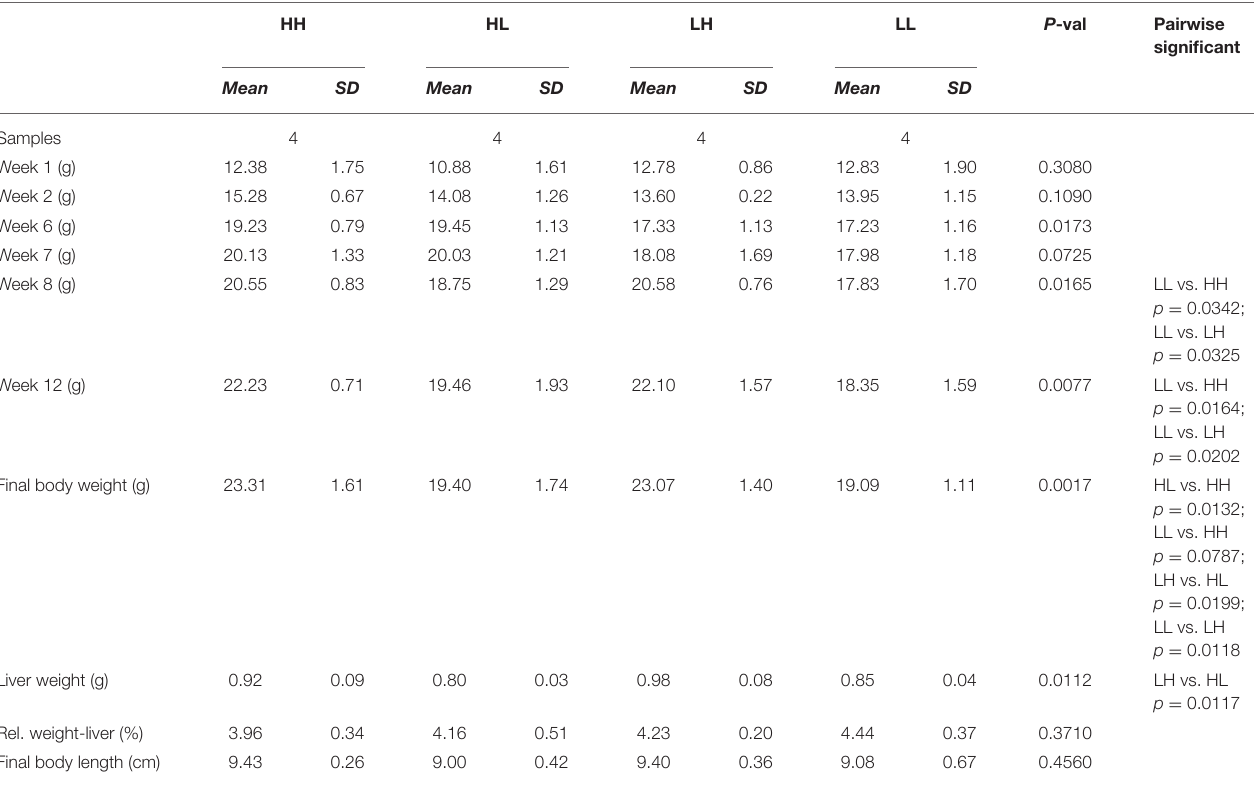
TABLE 1 | Basic description of the sample used for transcriptomic profiling by RNA-sequencing.